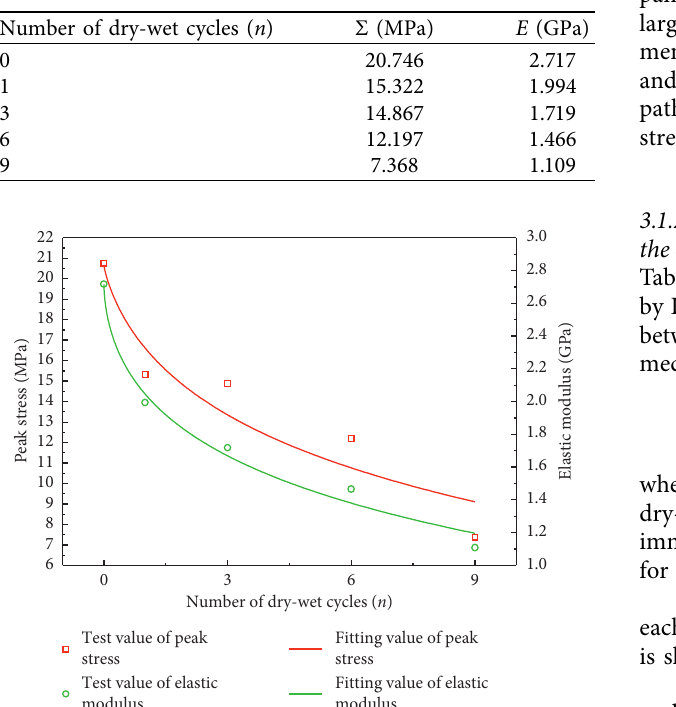
Figure 6: Uniaxial stress-strain curve of the red sandstone Table 2: Changes in the uniaxial mechanical parameters of the red sandstone.